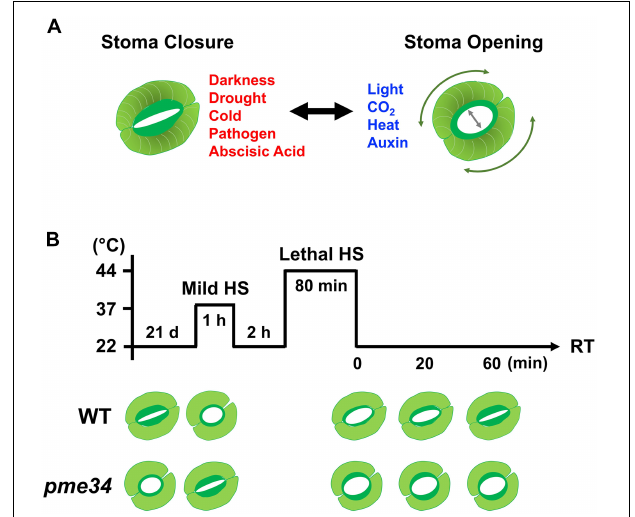
FIGURE 5 | Arabidopsis PME34 regulates the stomatal aperture under heat stress. (A) The inner wall of a guard cell is thicker and more elastic than the outer cell wall to facilitate the opening of the stomatal pore. The elastic property of the guard cell wall acts reversibly during stomatal opening and closing owing to differential thickening and the orientation of cellulose microfibrils (expressed in threads). The openings and closures of the stomata pore are strictly regulated by the integration of environmental stimuli and endogenous hormonal signals. (B) Comparison of elevated temperature stimulated-stomatal opening in wild-type (WT; Col) and pme34 mutant plants. Leaves (21-day-old) of WT and pme34 plants were treated with 37 ◦ C-mild and 44 ◦ C-lethal heat stress (LHS), respectively, as indicated. The pictogram shows the HS regime and the schematic diagram in the lower panel indicates the response of the stomatal aperture. Under normal condition, pme34 plants had a larger stomata aperture compared with that of WT plants. Under mild-HS treatment, the stomatal apertures in WT plants increased for aiding the dissipation of heat, whereas those of pme34 plants did not. Following the further 44 ◦ C LHS at recovery time (RT), stomatal apertures of pme34 were opened wider than those of WT plants, indicating greater water loss than that in WT